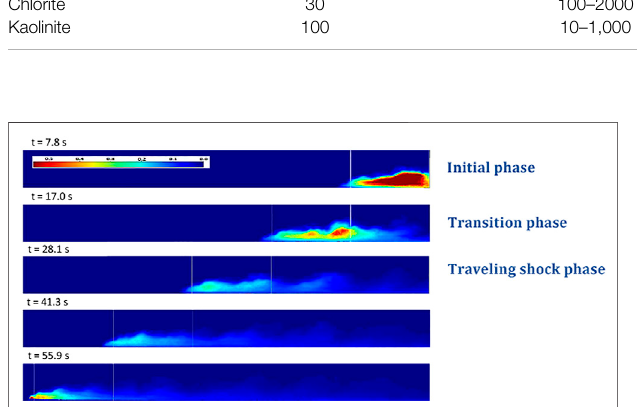
FIGURE 2 | Results of low concentration suspended sediment lock- exchange experiment, depicting the different phases of a particle-driven current, (Helmons et al., 2019)